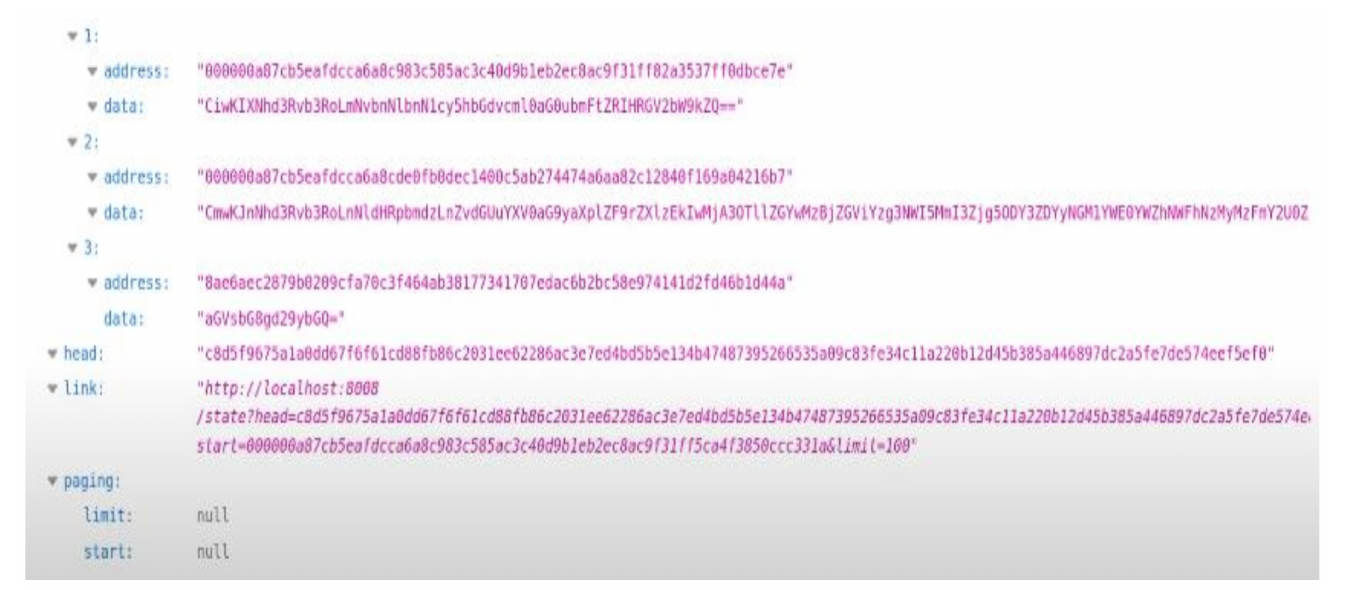
Figure 11. Hash-encrypted power-related data stored and exchange details among the participating stakeholders and connected in the chain-like structure